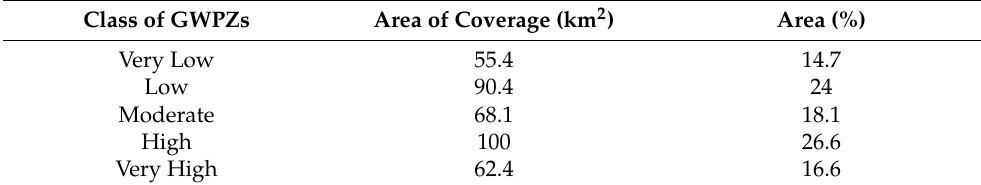
Table 6. Groundwater potential zone derived from